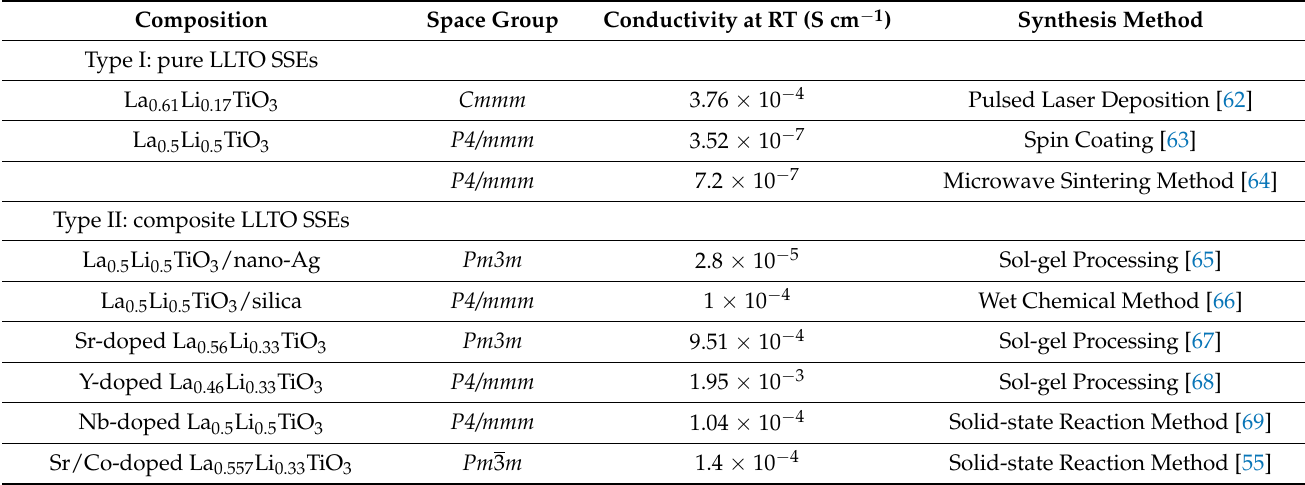
Table 2. Summary of selected LLTO SSEs in ionic